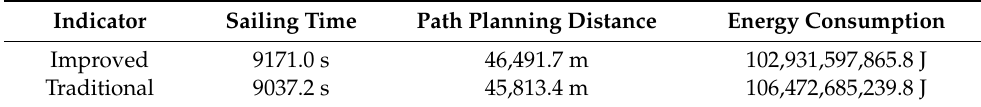
Table 2. Index comparison between improved and traditional ant colony